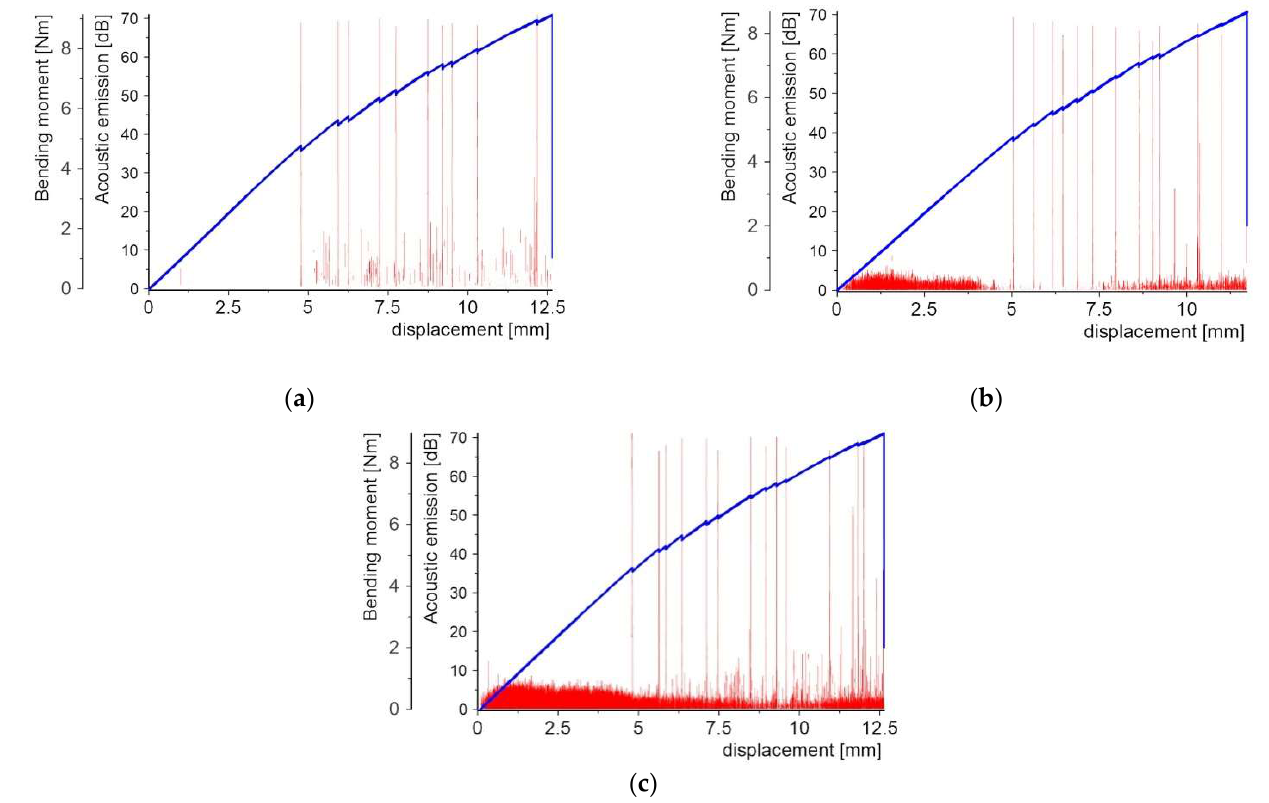
Figure 8. Bending moment and AE vs. displacement diagrams for 3 specimens with a PL made of copper powder: ( a ) sample 1_1; ( b ) sample 1_2; and ( c ) sample 1_3.